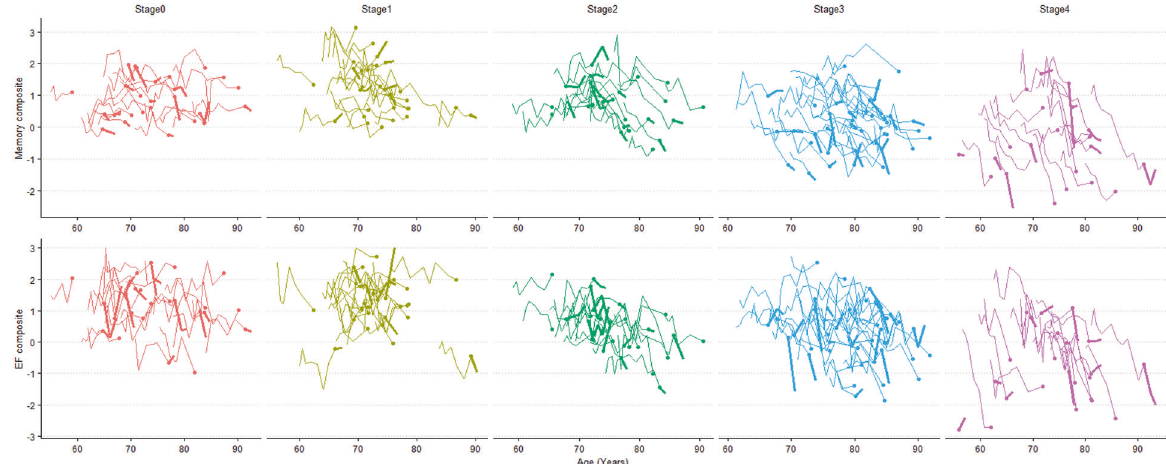
Fig. 5 Trajectories of memory and executive function versus age by tau stage. Each line represents one participant ’ s trajectory, with the dot indicating the baseline, the thinner part of the line indicating the measures before the baseline, and the thicker part of the line indicating measures after the baseline. Participants showed a perceivable decline in stage 1, 2, 3, or 4 for memory composite and in stage 2, 3, or 4 for EF composite. The differences in rates of cognitive decline between stages were characterized using linear mixed-effects models (results shown in Fig. 4). For the panel of stage 2, a random subset of 20% of the data is shown to reduce overlap in the lines. EF executive